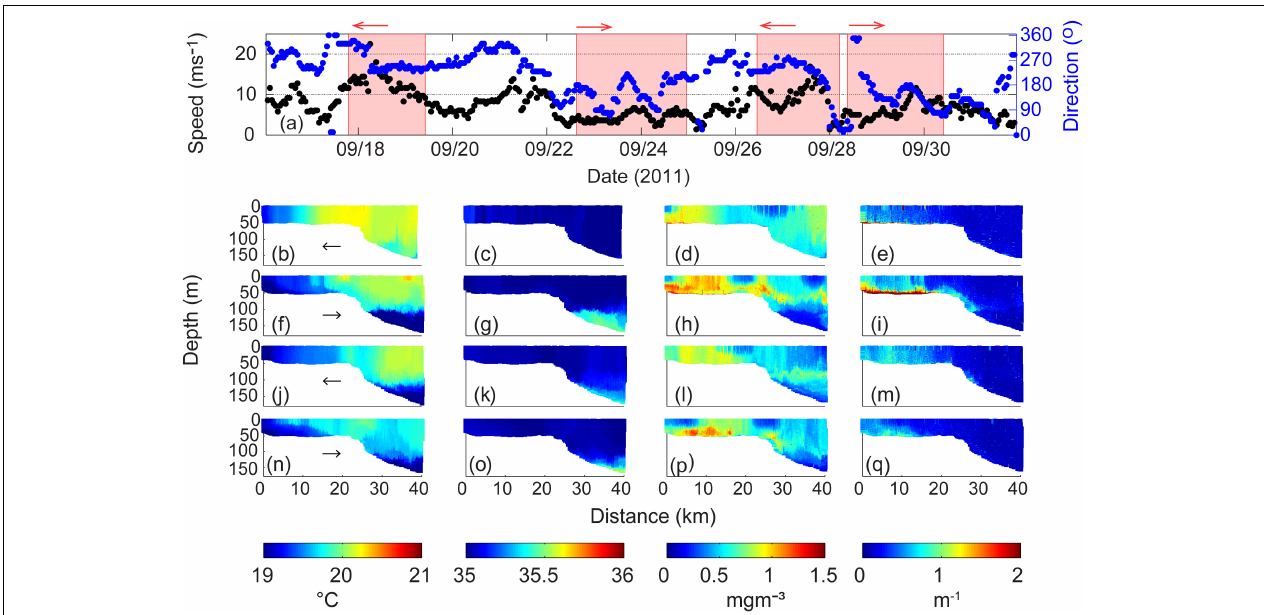
FIGURE 5 | (a) Wind speed and direction at Rottnest Island during 17–30 September 2011. The shaded areas represent the period of ocean glider transect; Ocean glider vertical cross-sections of (b) temperature ( ◦ C); (c) salinity; (d) chlorophyll (mg m − 3 ); and (e) backscatter (m − 1 ) across the Rottnest continental shelf